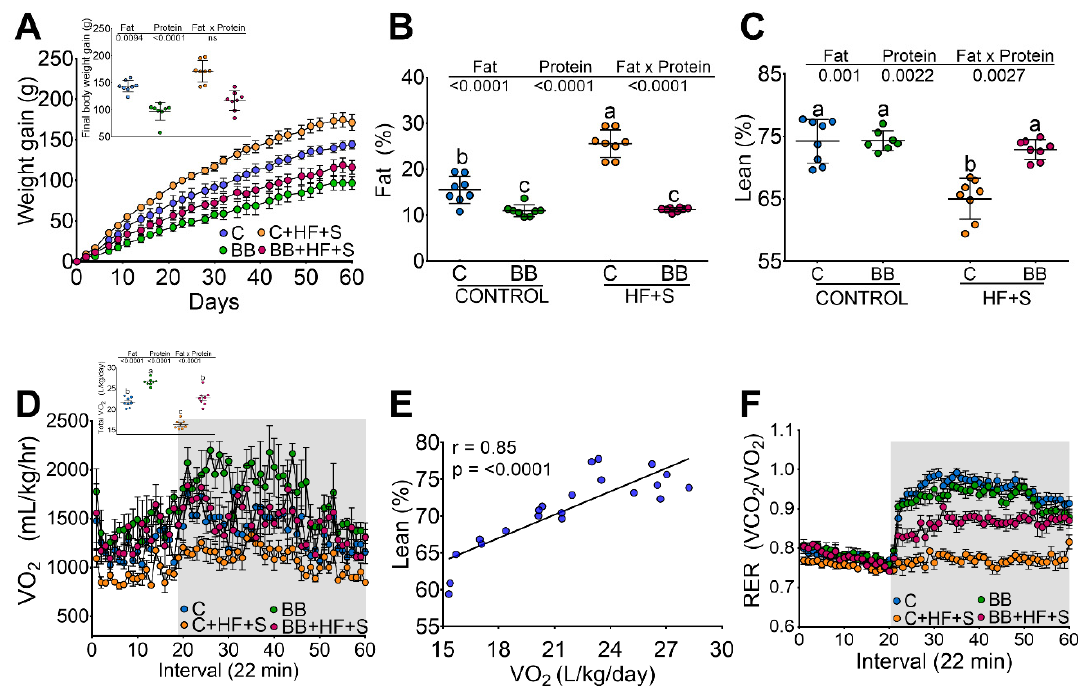
Figure 1. Black bean maintains lean mass and reduces body fat by increasing energy expenditure. ( A ) Weight gain after the consumption of casein ( C ), black bean (BB), C + high-fat + 5% sucrose (HF + S) (C + HF + S), BB + HF + S for 2 months. Inset: final body weight. ( B ), body fat, ( C ), lean body mass. ( D ) oxygen consumption, ( E ) correlation between lean mass and oxygen consumption, ( F ) respiratory exchange ratio (RER), n = 8 per group.